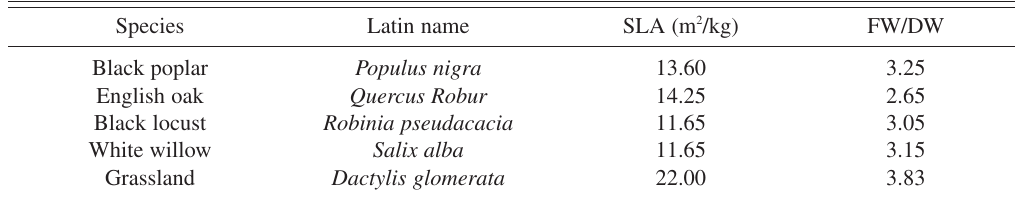
Table III. Specific Leaf Area (SLA) and ratio between fresh and dry weight (FW/DW) values.